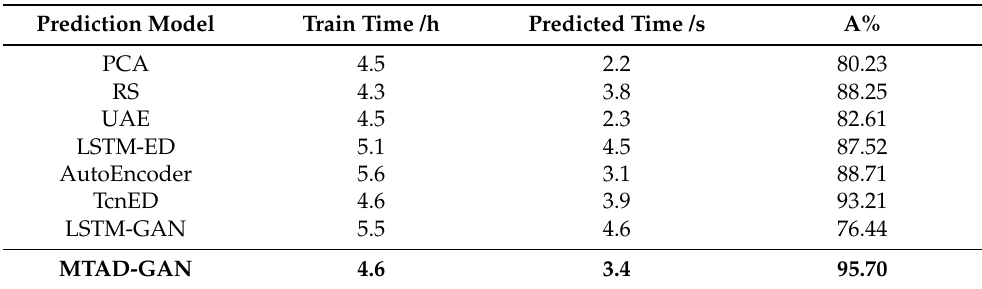
Table 5. Performance comparison of the time and accuracy of different baseline methods with